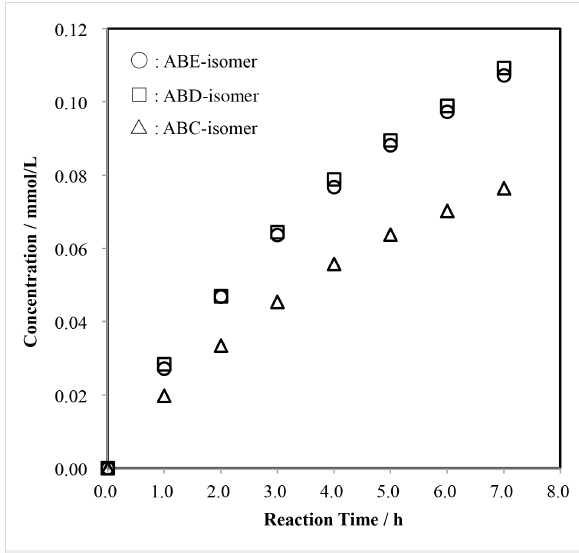
Figure 9: Time-course of the formation of the regioisomers of tri-6- O - trityl- α -CD in a reaction of the AB-isomer with TrCl in pyridine at 55 °C. Average mole ratios of ABC:ABD:ABE = 0.71 ± 0.01:1.00:0.98 ± 0.01.